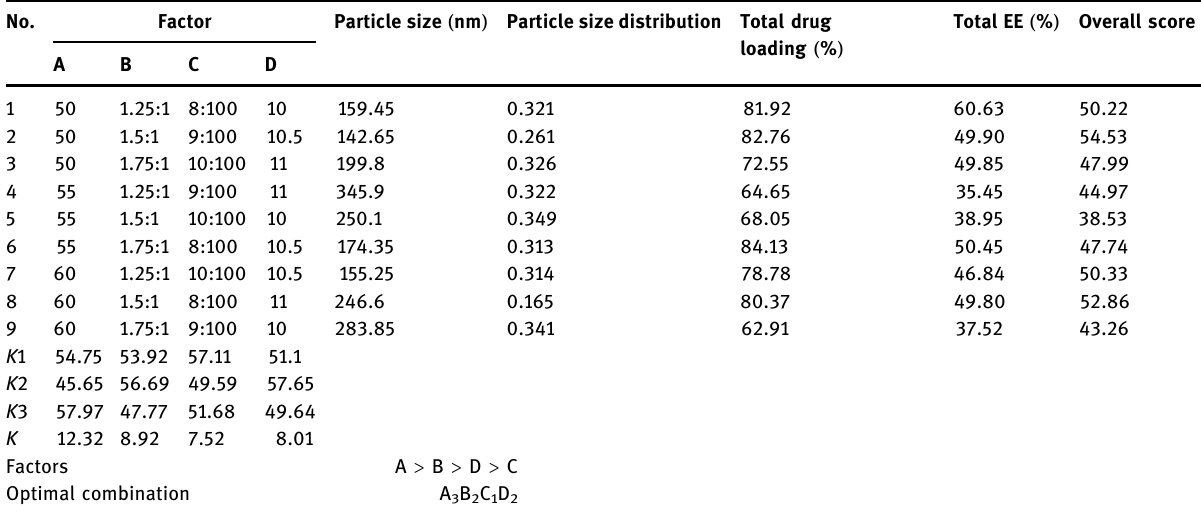
Table 3: Orthogonal table of the niosomal complex suspension prescriptions No.